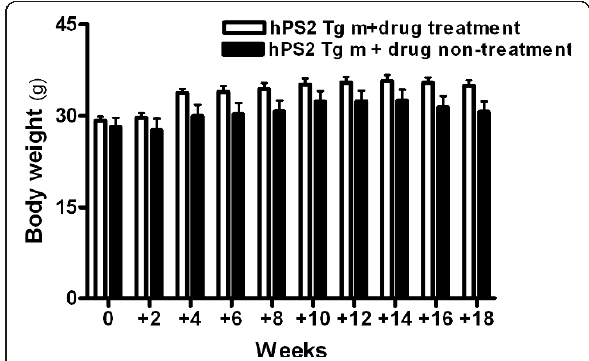
Figure 1 Change of the body weight of the experimental mice . The body weight of the hPS2 transgenic mice and the drug treated-hPS2 transgenic mice at 0, 2, 4, 6, 8, 10, 12, 14, 16 and 18 days following drug treatment (n = 4-5/group). The data shown are the means ± S.E.M (n =